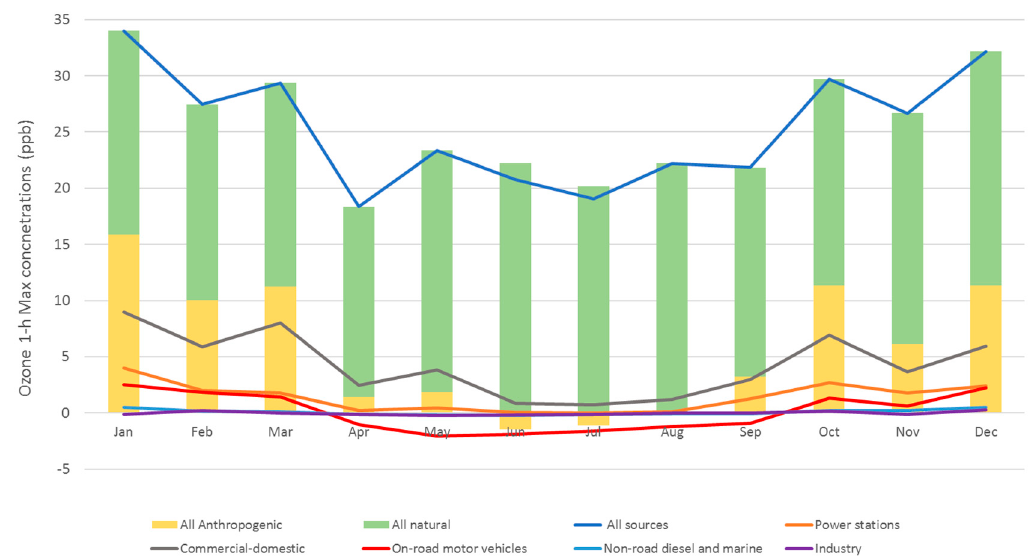
Figure A7. Contribution of all anthropogenic and natural emissions (bar graph) and different anthropogenic sources (line graph) to the monthly average of daily maximum 1-hour ozone concentration in 2008 in the Illawarra region.